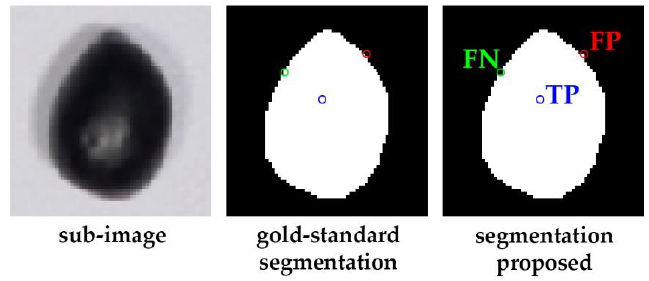
Figure 4. Examples of the different categories of pixels established to evaluate the segmentation results: true positives (TP, in blue); false positives (FP, in red); false negatives (FN, in green).